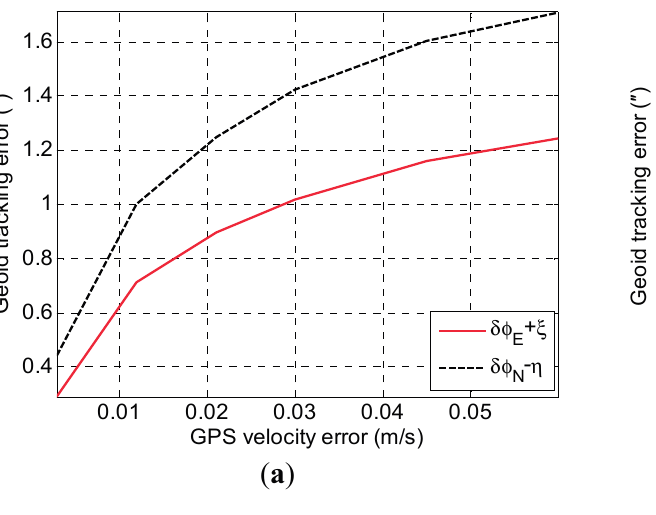
Figure 8. ( a ) Geoid tracking error with different GNSS accuracy; ( b ) the geoid tracking error with respect to the accelerometer noise; ( c ) the geoid tracking error with respect to the gyro noise; ( d ) The geoid tracking error with respect to travel